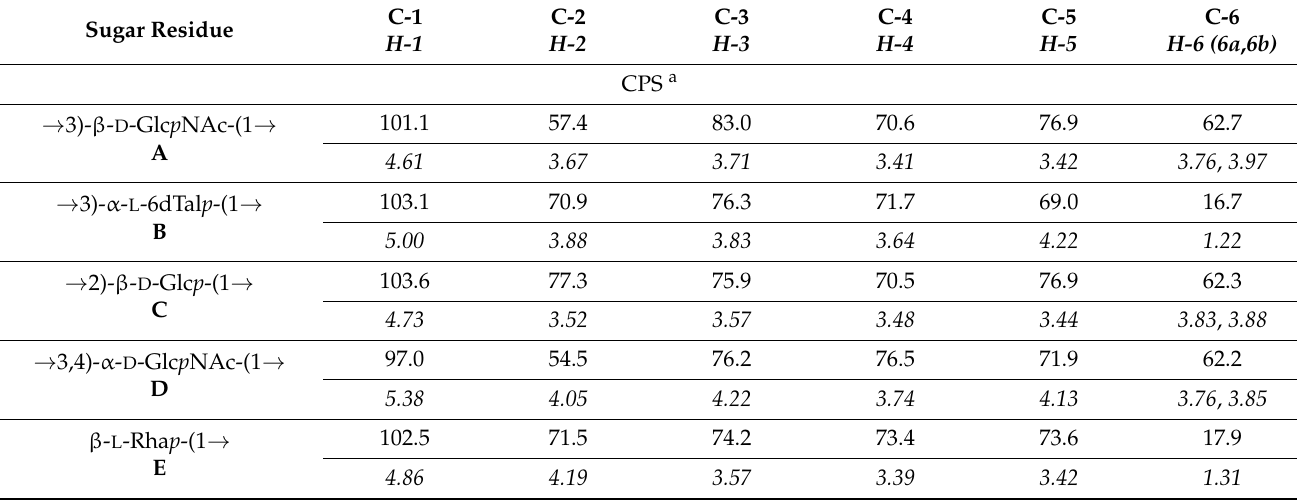
Table 2. 1H and 13C NMR chemical shifts ( δ , ppm) of the K112 capsular polysaccharide of A. baumanii MAR24 and oligosaccharides OS2 and OS3 derived by Smith